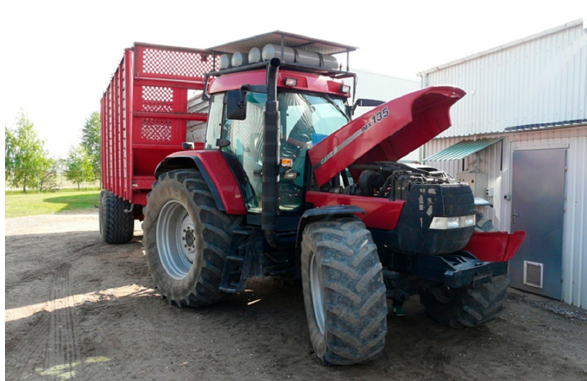
Figure 2. View of the Case IH MX 135 agricultural tractor.